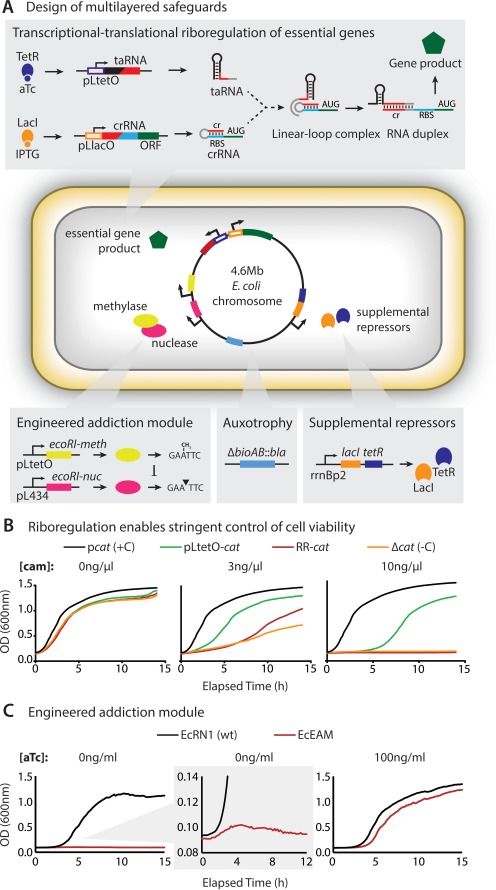
Design of multilayered genetic safeguards: riboregulation, engineered addiction, auxotrophy and supplemental repressors. (A) Riboregulation system: pLtetO promoter (19), repressed by TetR and induced by aTc, drives trans-activating (taRNA); pLlacO promoter, repressed by LacI and induced by IPTG, drives cis-repressed (crRNA) and essential gene. crRNA and taRNA fold through a linear loop intermediate to reveal the crRNA's RBS permitting expression (green). Supplementary TetR (purple) and LacI (green) are constitutively expressed from the genome. Carbenicillin resistance gene (bla) replaces bioAB, resulting in biotin autotrophy (blue). Constitutive EcoRI nuclease (magenta) enables inducible cell killing in the absence of EcoRI methylase (yellow), which is controlled by aTc. (B) Riboregulation system controls cell viability. Chloramphenicol (cam) resistance of strains carrying cat gene regulated in different ways, all grown without inducers. Constitutive (black, + control); pLtetO (green, non-riboregulated control); riboregulated (red); no cat (orange, - control). (C) Kinetic growth curves demonstrate dependence of engineered addiction system (strain EcEAM) on aTc.